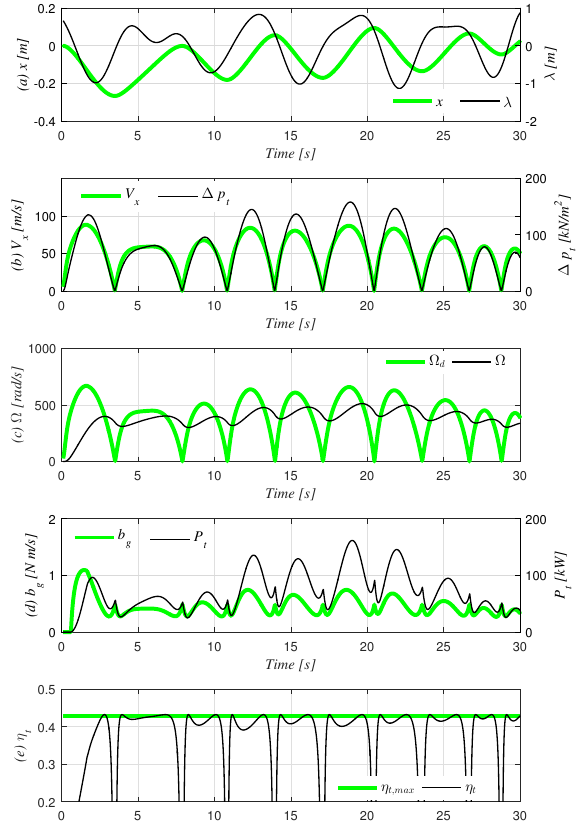
Figure 4. Simulation result of the first 30 s with the instantaneous-maximum efficiency tracking (i-MET) controller when k p = 0.5: ( a ) wave λ and water column positions x ; ( b ) airflow speed at the turbine duct V x and pressure drop across the turbine ∆ p t ; ( c ) turbine rotor angular velocity Ω and its desired value Ω d ; ( d ) generator damping coefficient (control input) b g and power extraction from the turbine P t ; ( e ) turbine efficiency η t and its maximum value η t , max